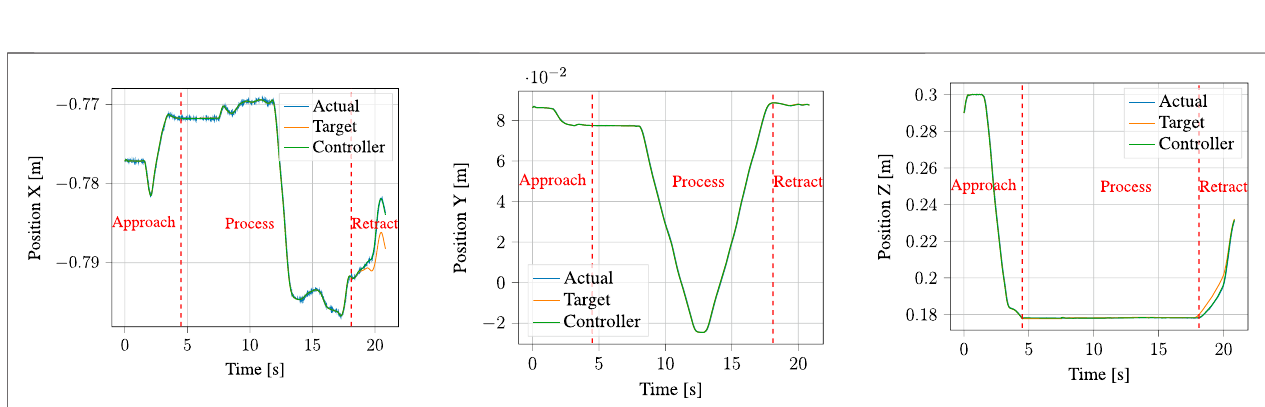
FIGURE 14 | Target forces input to the parallel position/force controller (labelled target ) compared to the actual measured forces (labelled actual ). The dotted verticalred lineshows the point at which contact with thesurface wasdetected, uponwhichthe gainsofthe parallel position/force controllerare adapted and theforces are ramped to the target process force magnitude.